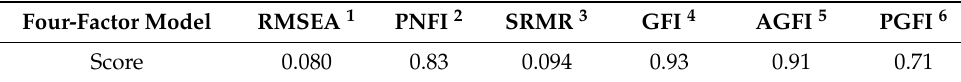
Table 2. Construct validity of the ICSR.